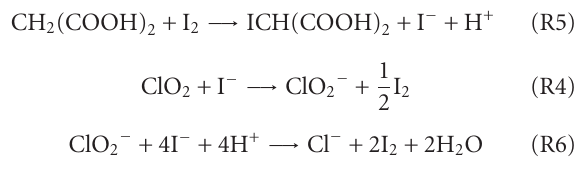
Figure 9: The absorbance versus reaction time for ClO 2 -I − -H + system at 460 nm ( r = 0 . 52): curve 1: pH = 7 . 0; curve 2: pH = 5 . 7; curve 3: pH = 5 . 0; curve 4: pH = 4 . 5; curve 5: pH = 4 . 0; curve 6: pH = 3 . 6; curve 7: pH = 2 . 0; curve 8: pH = 1 .